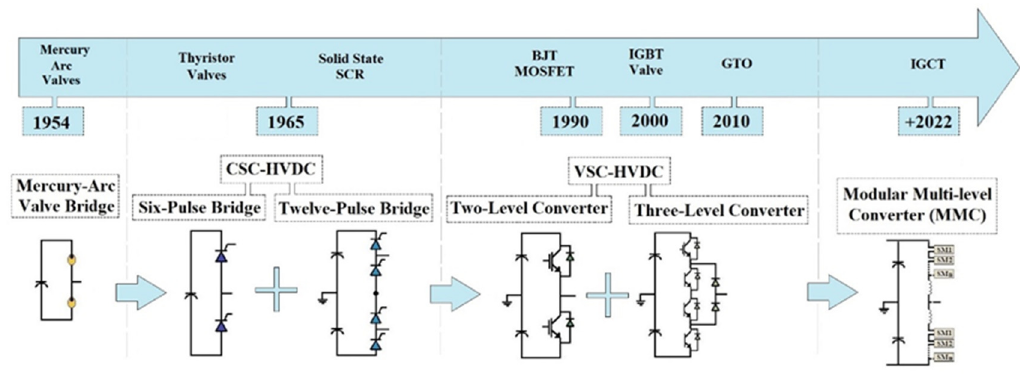
Figure 1. HVDC technological evolution.